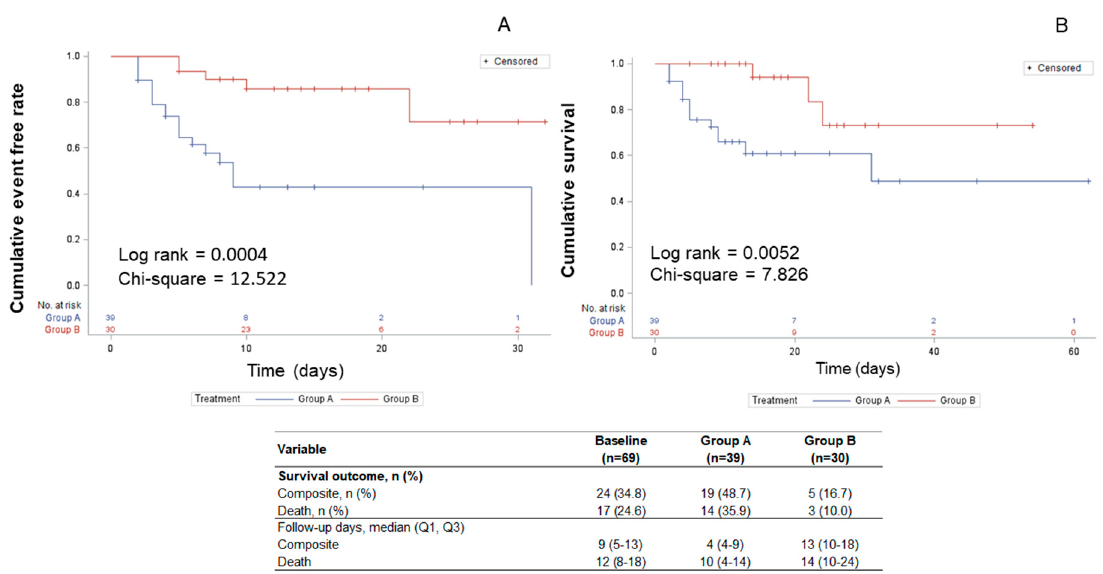
Figure 1. Kaplan–Meier analysis for composite outcome ( A ) and mortality ( B ). Cumulative event-free rate and survival are represented (group A, stippled line; group B continuous line). The respective log rank and chi-square values are reported.